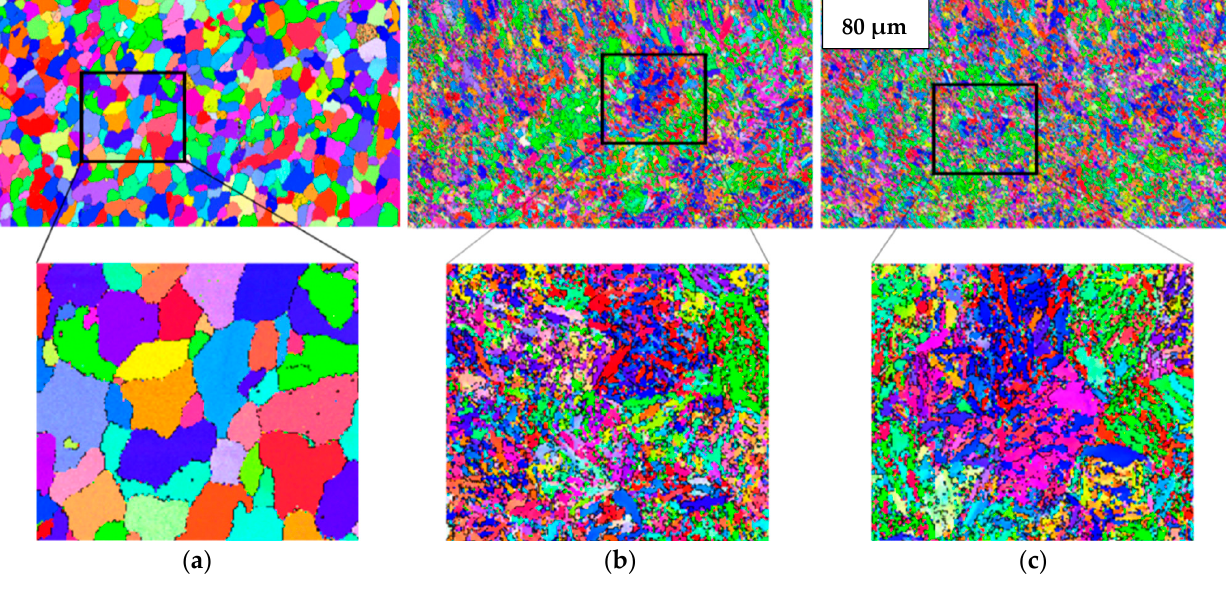
Figure 2. Inverse pole figure map obtained from EBSD analysis for ( a ) untreated, ( b ) heated and ( c ) cryo specimens.